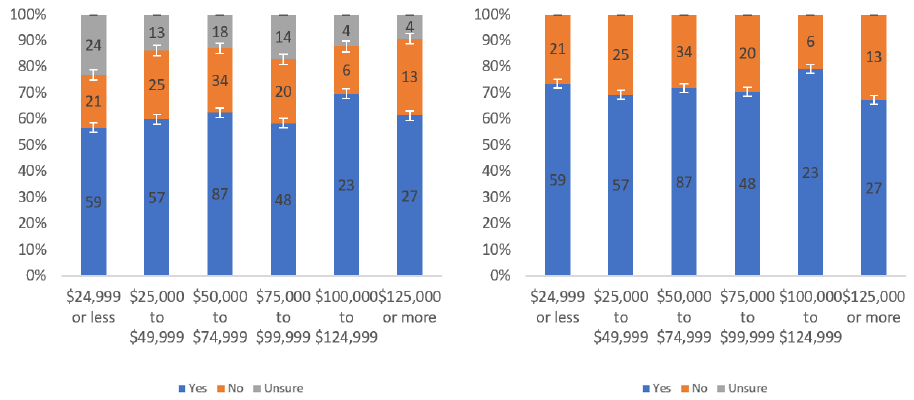
Figure 19. Responses regarding usefulness in judging trustworthiness by income level including ( left ) and excluding ( right ) unsure responses.